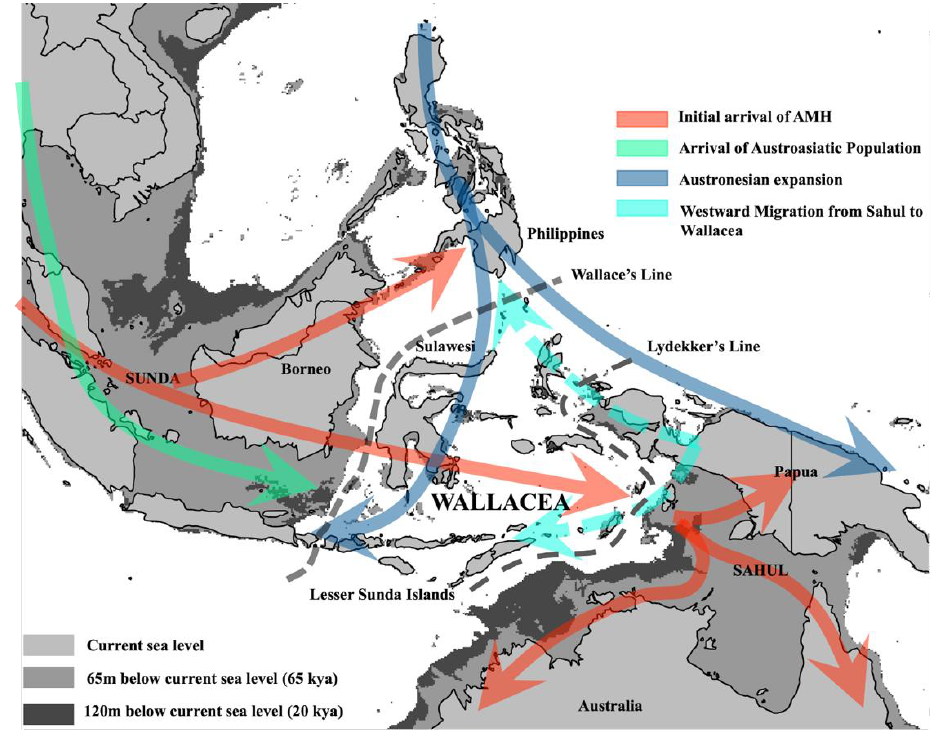
Figure 2. Schematic representation of putative AMH population movements into ISEA and Sahul inferred from regional genetic data . Genetic inferences suggest that the initial peopling of the region occurred around 50–60 kya, with the separation of Aboriginal Australian and New Guinea populations occurring around the same time (red arrows; noting that this split may have occurred prior to the settlement of Sahul). Later migrations associated with the arrival of Austronesian seafarers introduced Ami-related ancestry into ISEA (blue arrows), and possibly also introduced MSEA-related ancestries at the same time (though the latter may have come from a separate movement; green arrows). Recent studies have emphasised that the presence of Papuan-related ancestry across Wallacea and the southern Philippines likely represents the movement of Papuan lineages into these regions (light blue dashed arrows), possibly in two distinct movements around 3 kya (i.e., potentially tied with Austronesian arrival) and 15 kya [39,43]. Not shown is an additional, albeit relatively minor, South Asian ancestry component in western Indonesia [38,45], which appears to coincide with the establishment of trading between these regions around 2000 years ago.